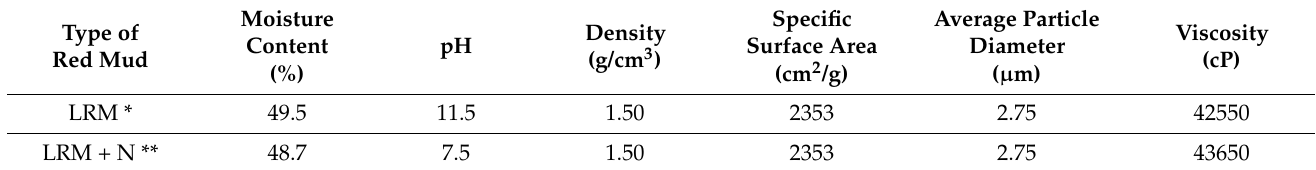
Figure 2. pH changes in the LRM + N samples over time. Table 1. Physical properties of red mud.